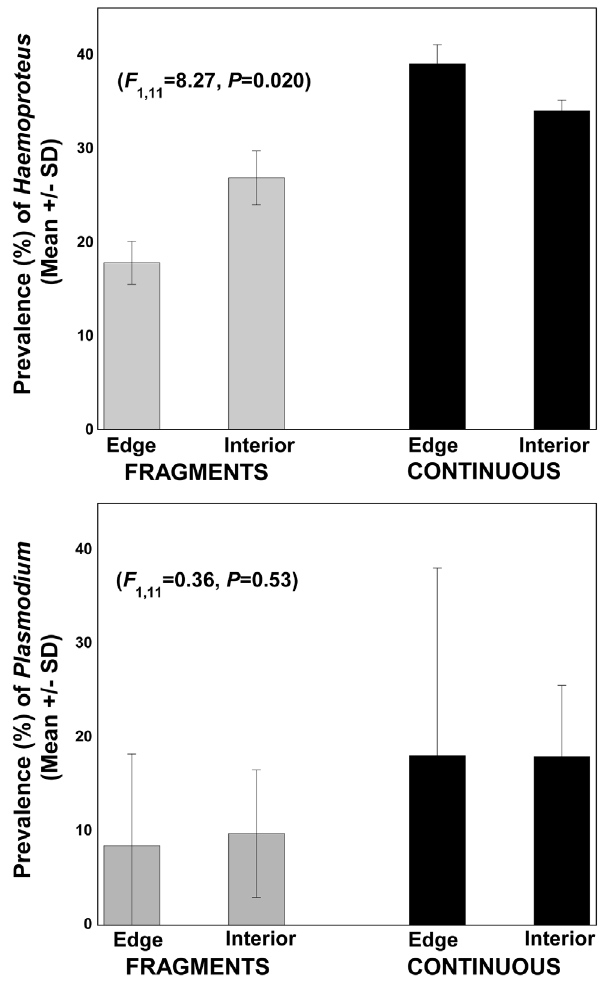
Figure 3. Habitat fragmentation reduced the prevalence of Haemoproteus (3A) and Plasmodium infections (3B) tropical rainforest of northern Australia.